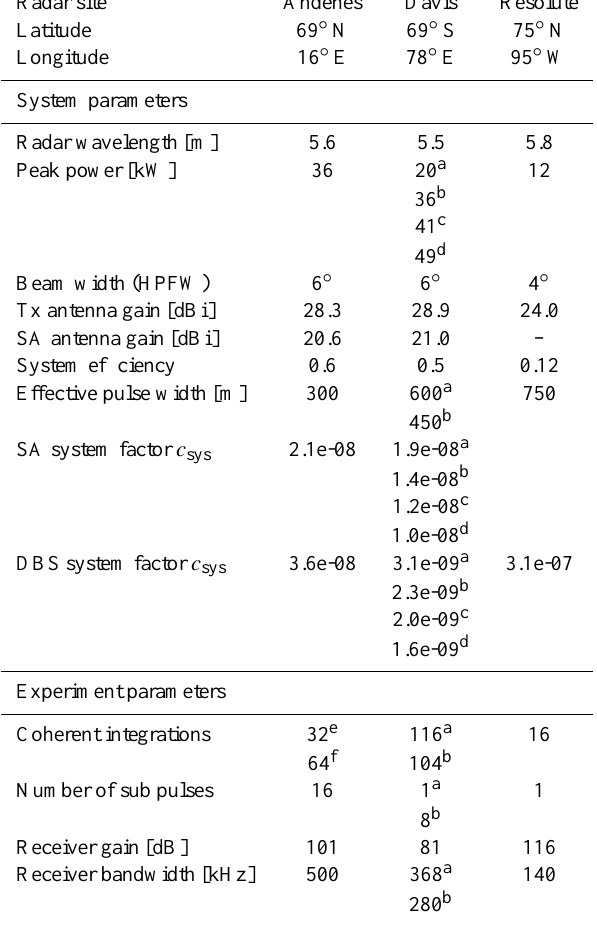
Table 1. Basic system parameters and experiment parameters of the VHF radars at Davis ( a ) before 24 January 2005, ( b ) since Septem- ber 2005, ( c ) since November 2005, ( d ) since October 2006, at An- denes ( e ) in 2004, ( f ) since 2005, and at Resolute Bay used for PMSE observation.